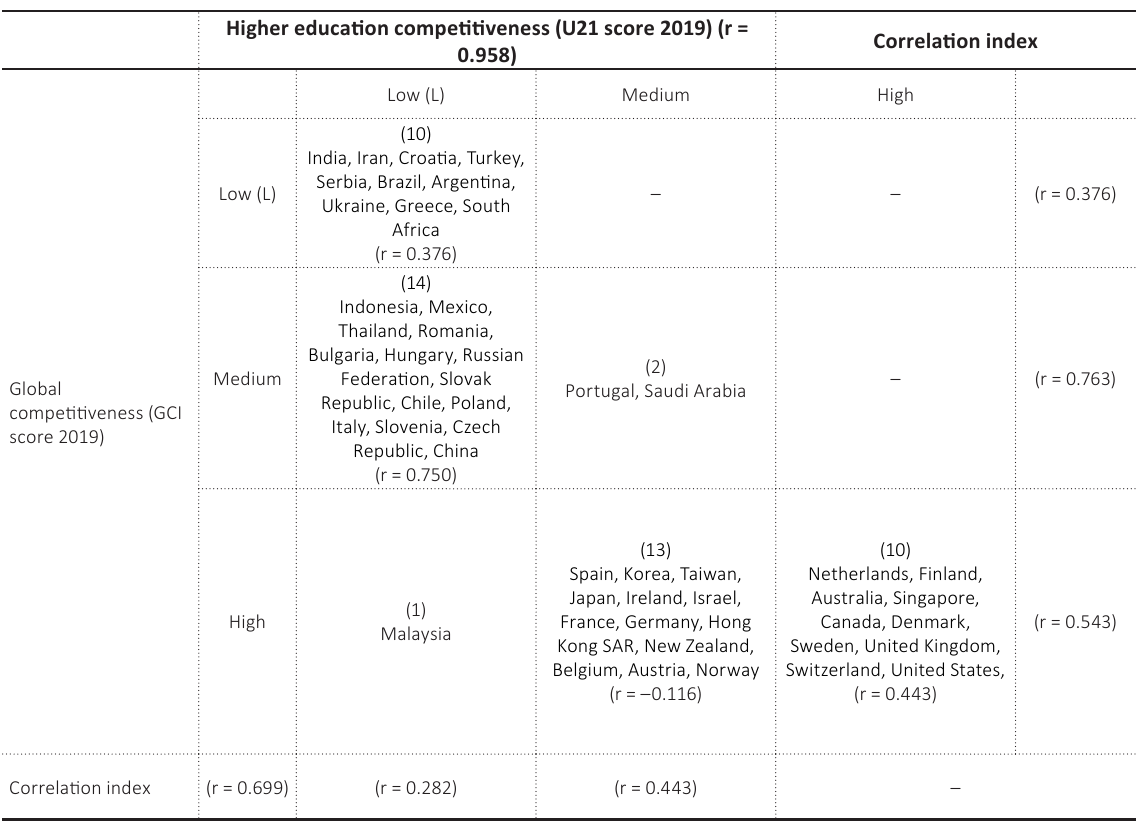
Table 3. Country distribution matrix based on the relationship between the level of higher education competitiveness and global competitiveness